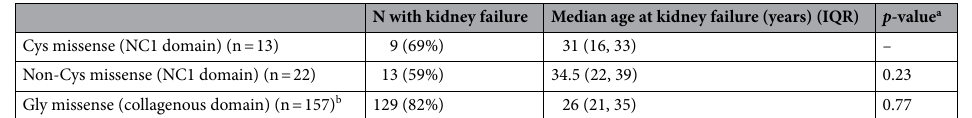
Table 2. Median ages at kidney failure for males with collagen IV α5 missense variants reported in LOVD. IQR Interquartile range. a Comparison with Cys missense (NC1 domain). b Data previously reported 27 .